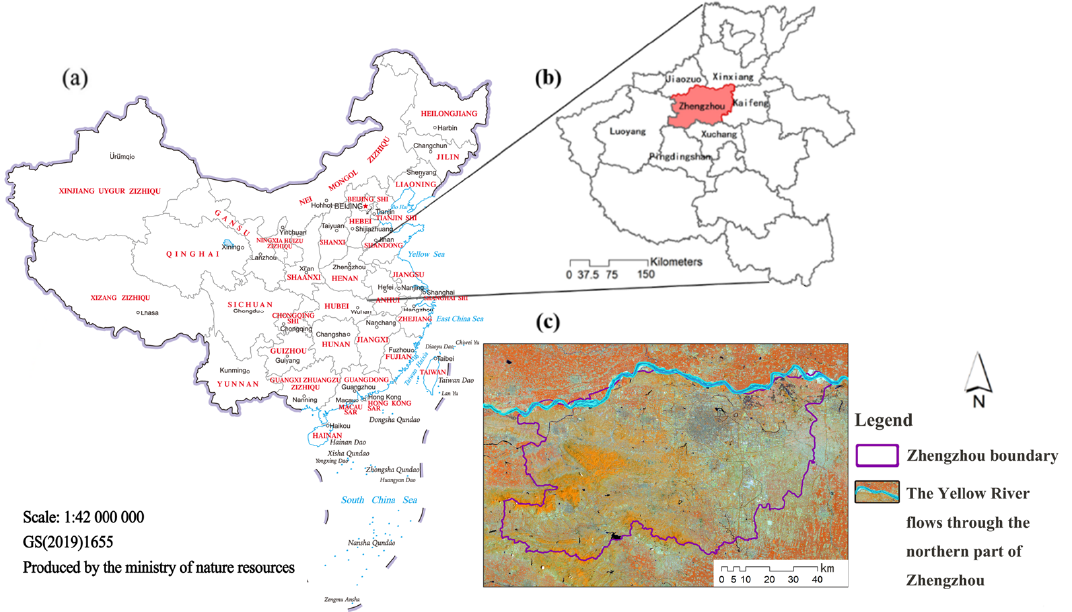
Figure 1. ( a ) Location of Zhengzhou, Henan Province, in China; gray lines indicate the boundaries of provinces and territories. ( b ) Henan Province; black lines depict city boundaries. ( c ) The blue line shows the boundary of Zhengzhou City, which can be seen to the north of Zhengzhou close to the Yellow River, the second-longest river in China.